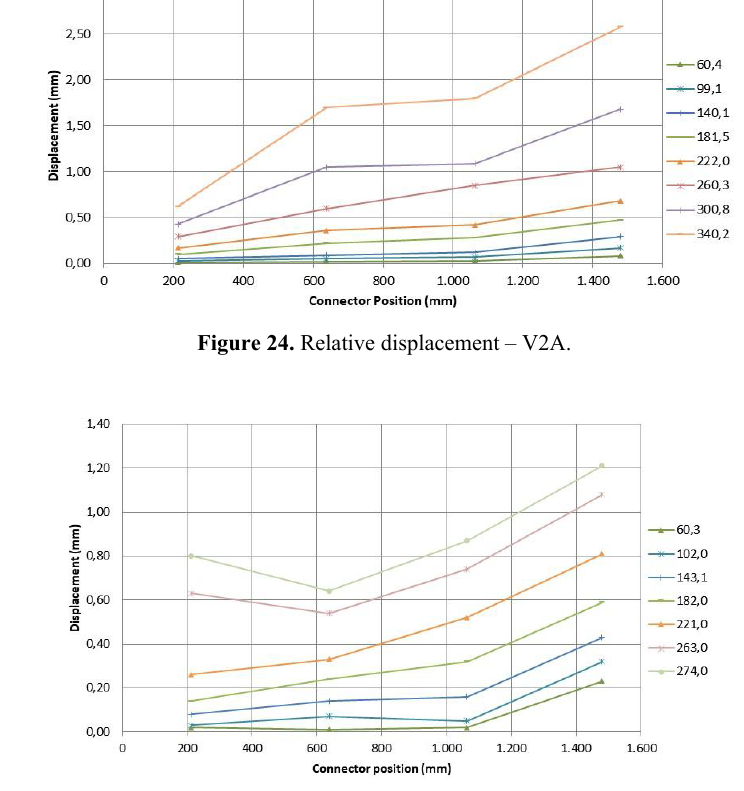
Figure 25. Relative displacement – V3A.